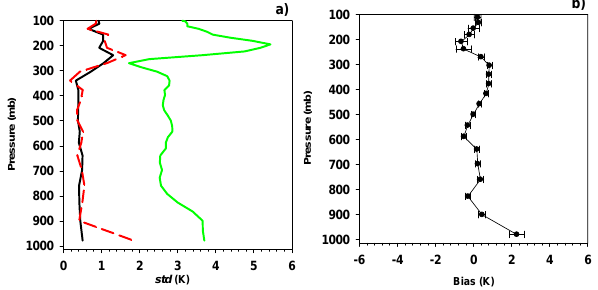
Fig. 4. Temperature retrieval errors. (a) black solid line is expected std error; red dashed line is the error assessed through validation; and green solid line is temperature profile variances as derived from radiosondes. (b) estimated bias, error bars indicate standard error.